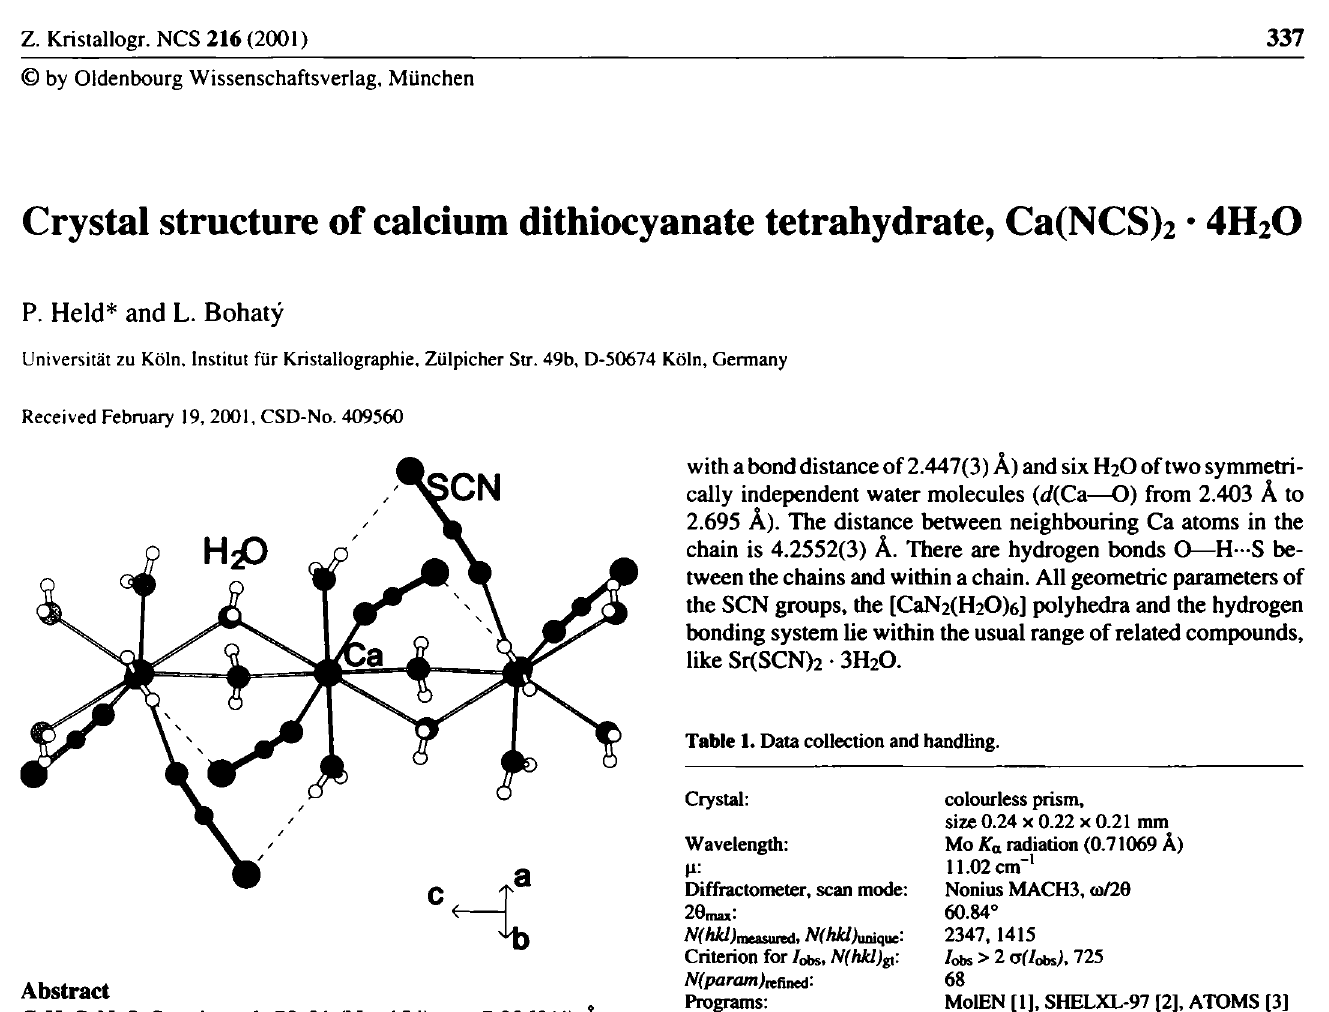
Table 2. Atomic coordinates and displacement parameters (in A 2 ).